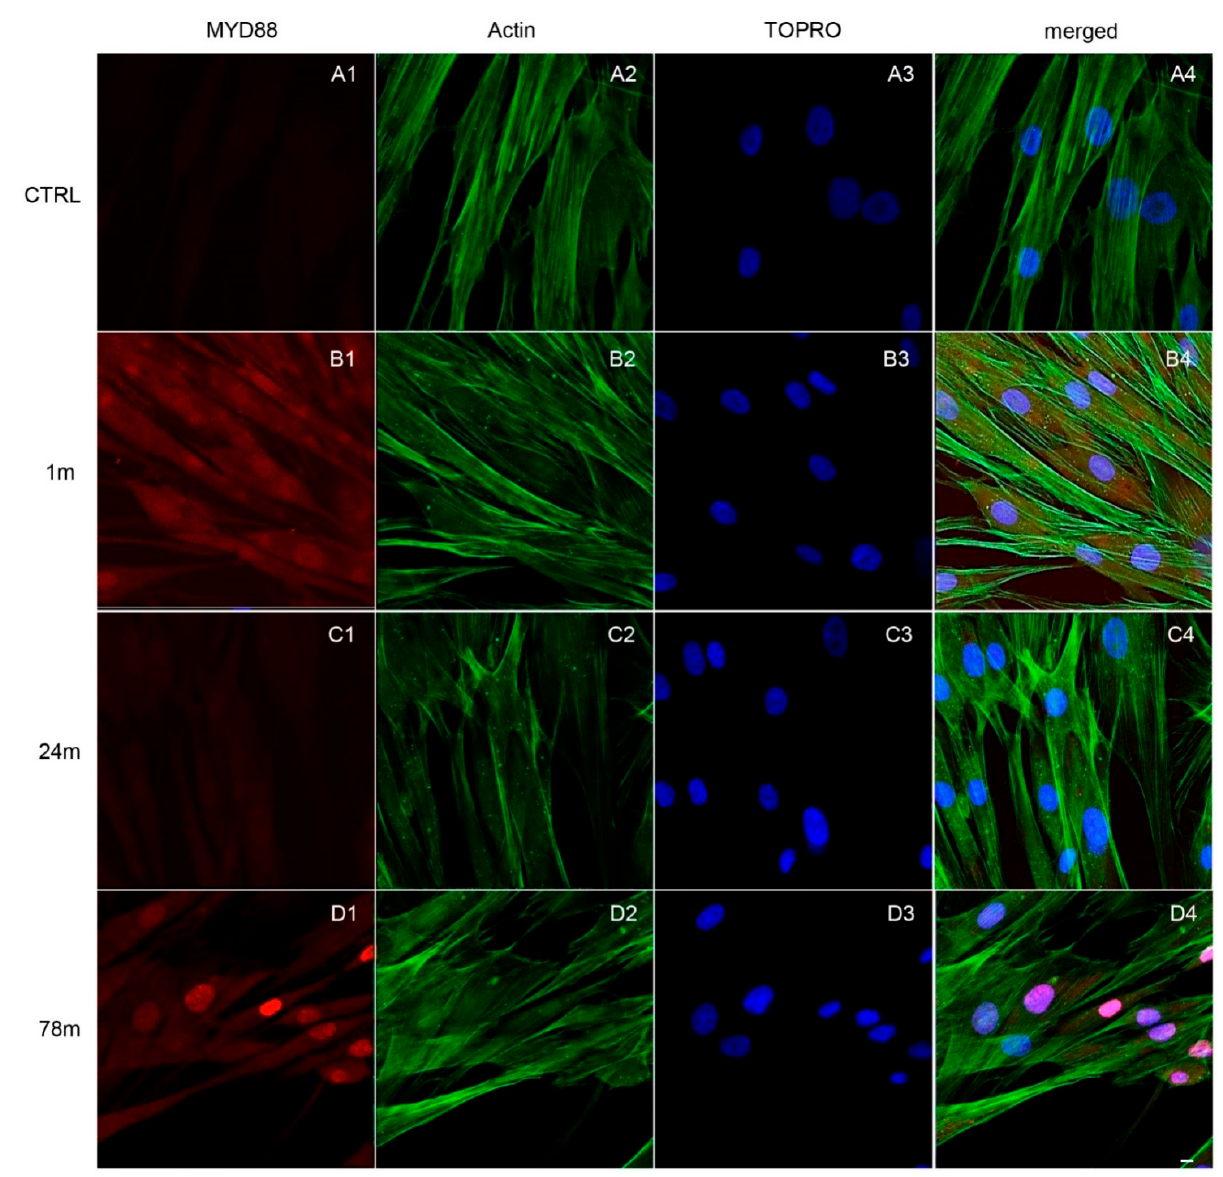
Figure 5. Immunofluorescence analysis of MYD88 expression on ( A1 ) CTRL cells and on cells exposed to ( B1 ) 1, ( C1 ) 24 and ( D1 ) 78 m MPs. ( A1 – D1 ) Red fluorescence: cytoskeleton actin; ( A2 – D2 ) green fluorescence: MYD88; ( A3 – D3 ) blue fluorescence: cell nuclei; ( A4 – D4 ) merged image of the above-mentioned channels. Scale bar: 20 μ m.